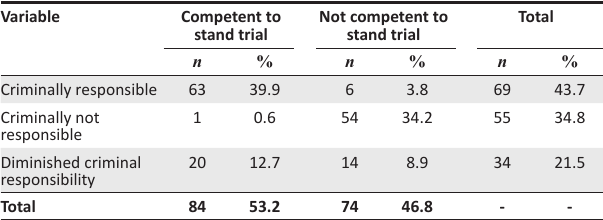
TABLE 3: Criminal responsibility and competency to stand trial ( n =